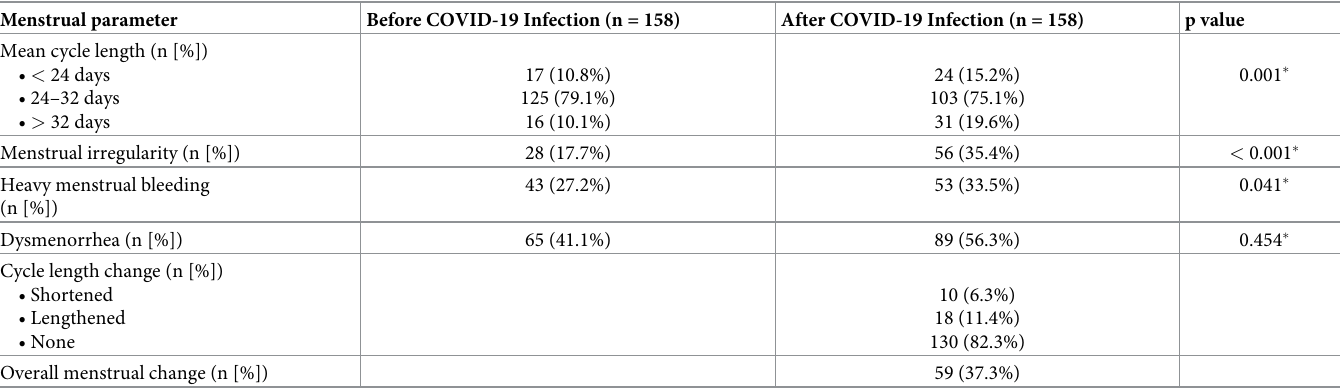
Table 2. Menstrual patterns.